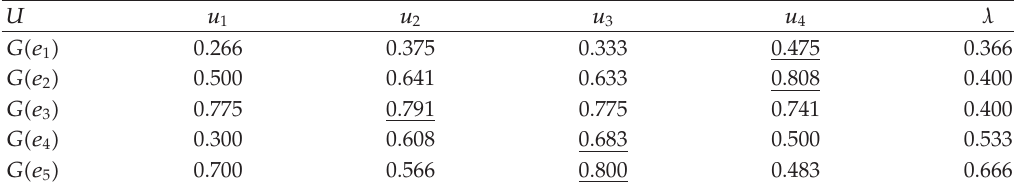
Table 9: Translation from GFSES—with multiopinion to GFSS.